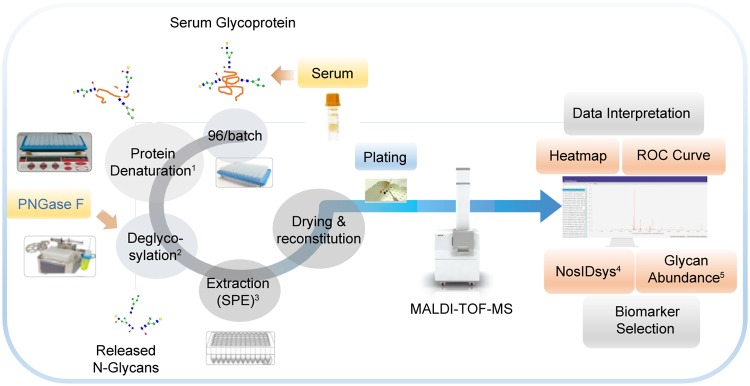
Schematic representation of procedures for the extraction, purification, and MALDI-TOF MS of serum N-glycans and analysis of data.1Denaturation, 2deglycosylation, 3solid-phase extraction (SPE), 4NosIDsys, and 5glycan abundance.